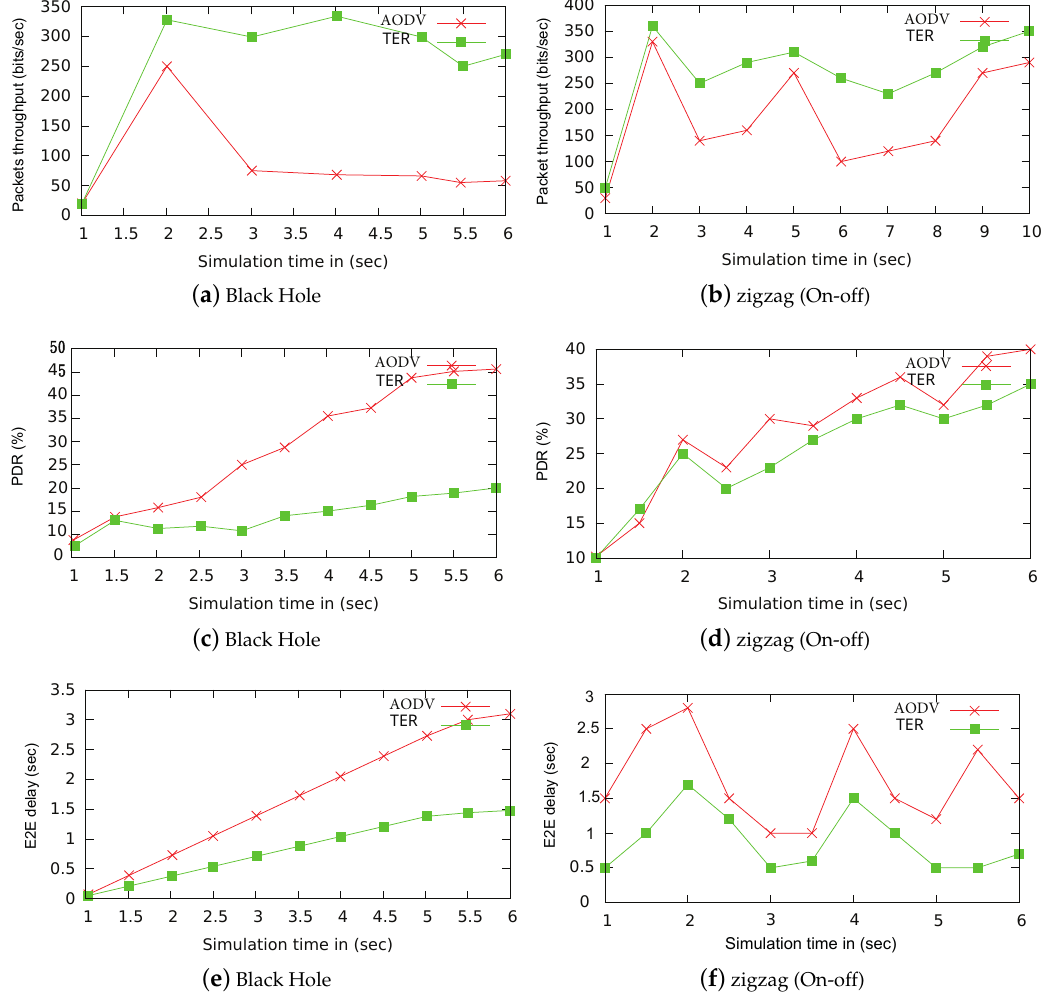
Figure 7. Packet throughput, PDR, and E2E delay under Black Hole and zigzag